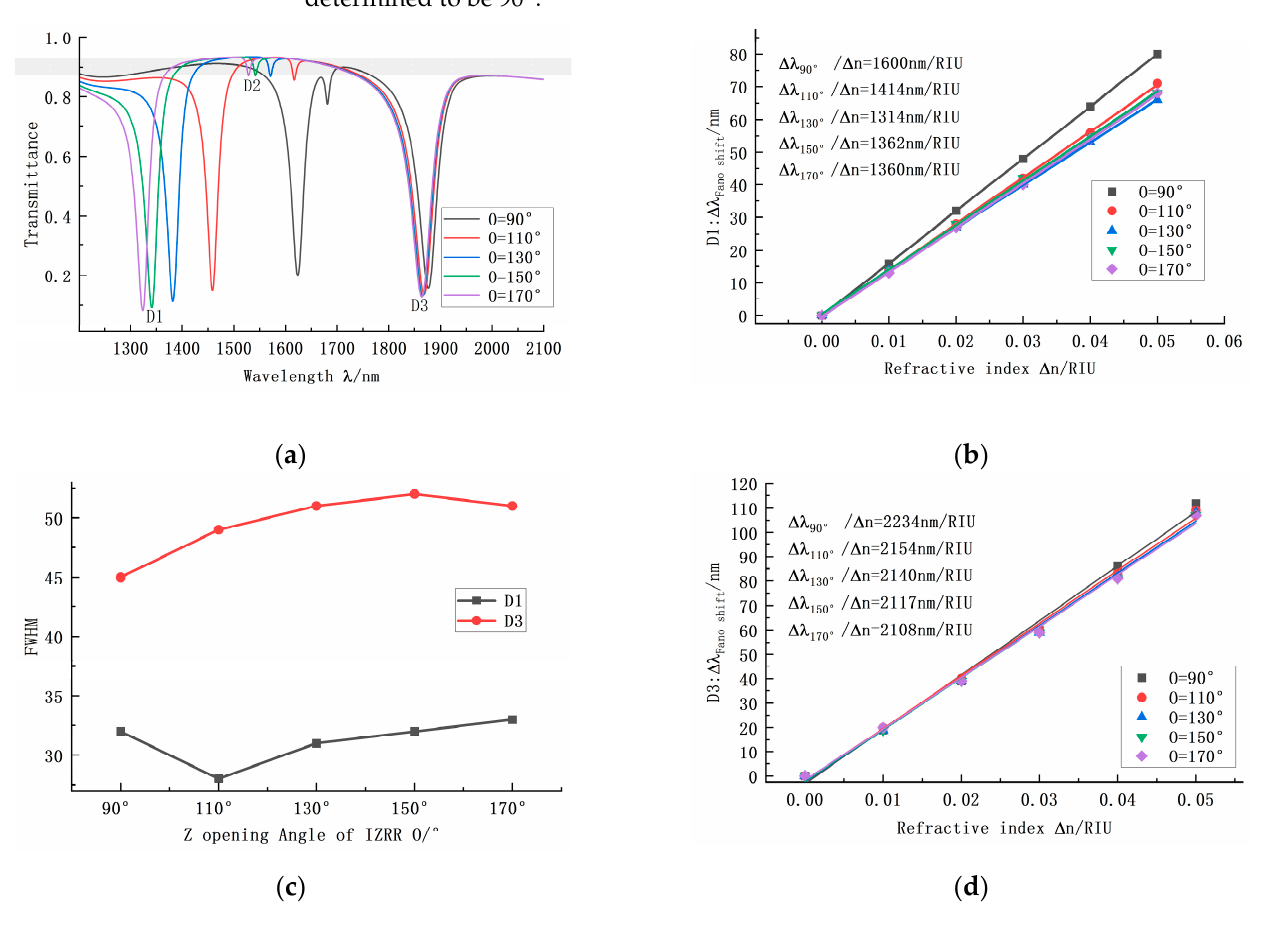
Figure 4. ( a ) Transmission curves of the IZZR structure under different Z-structure opening angles. ( b ) Sensitivity curve fitting at D1 under different ring radii. ( c ) Bandwidth variation at D1 and D3 under different Z-structure opening angles. ( d ) Sensitivity curve fitting at D3 under different ring radii.